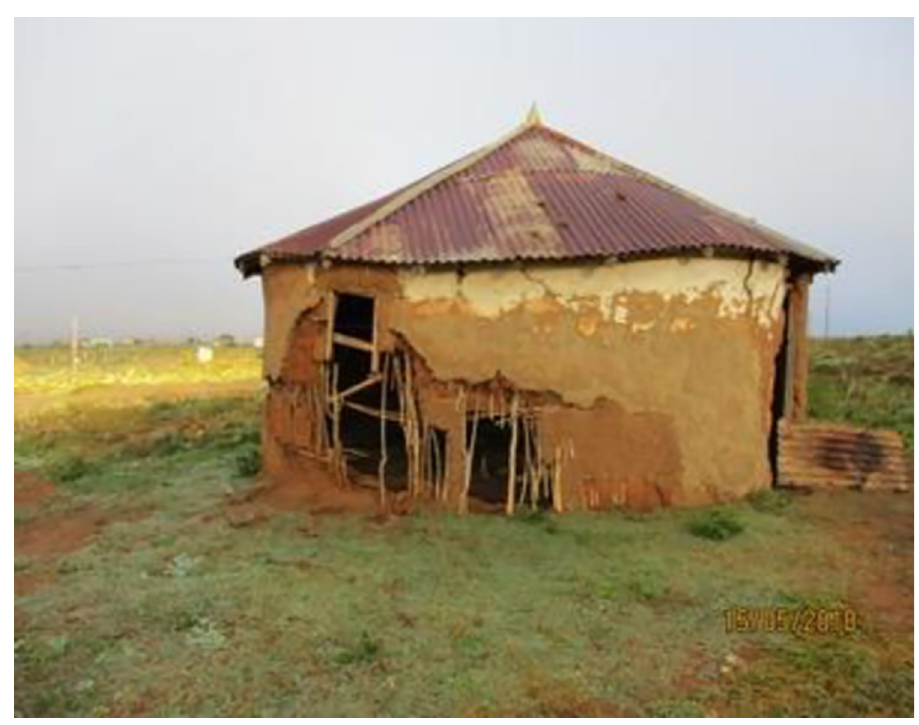
Fig 10. Image from co researcher 14–18.